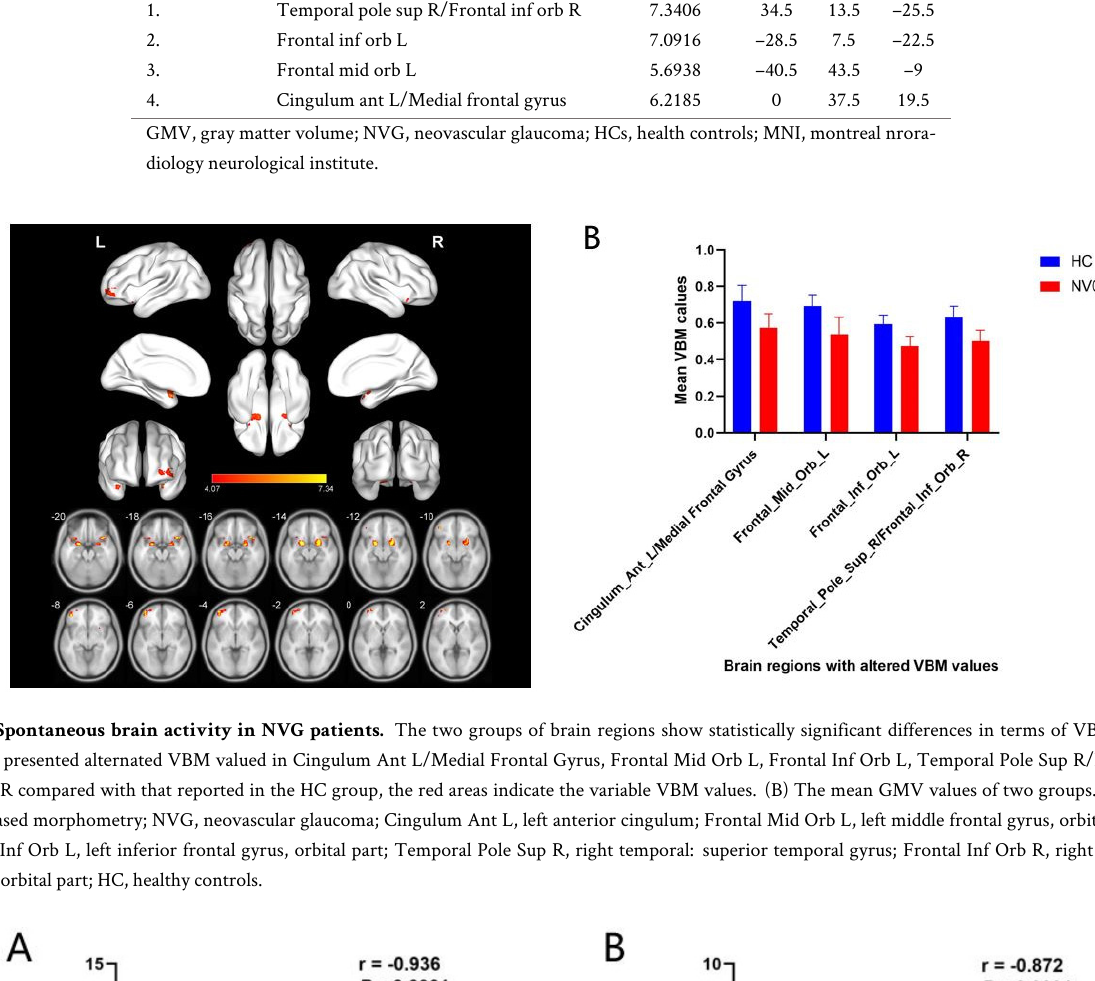
frontal gyrus, located anterior to the parasitical central